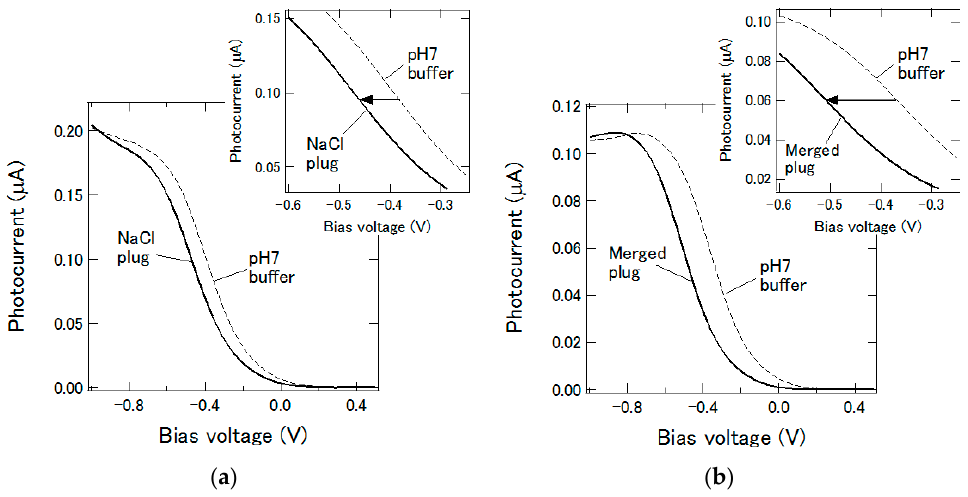
Figure 5. ( a ) I-V curves for the second plug measured in the upstream before merging; ( b ) I-V curves for the merged plug measured in the downstream.